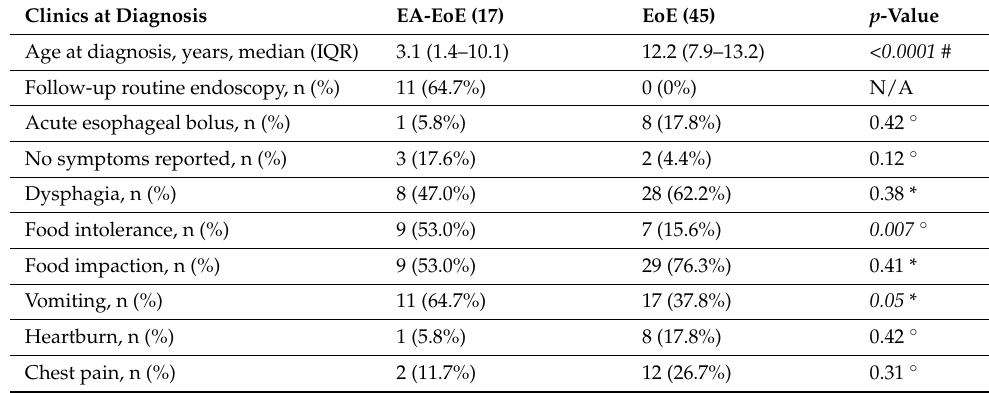
Table 2. Clinical features at diagnosis.